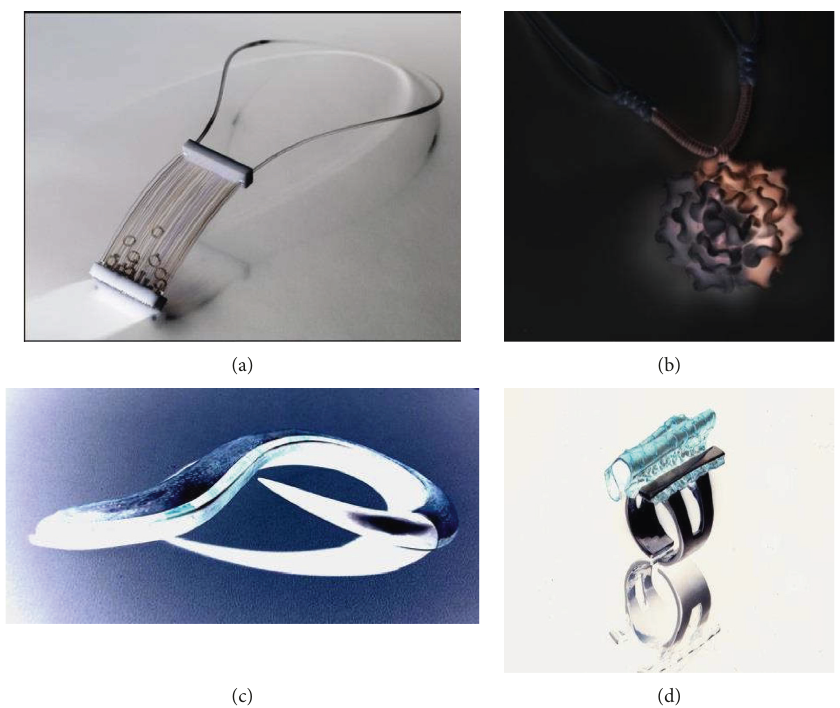
Figure 10: The rendering of jewelry art modeling design based on computer-aided